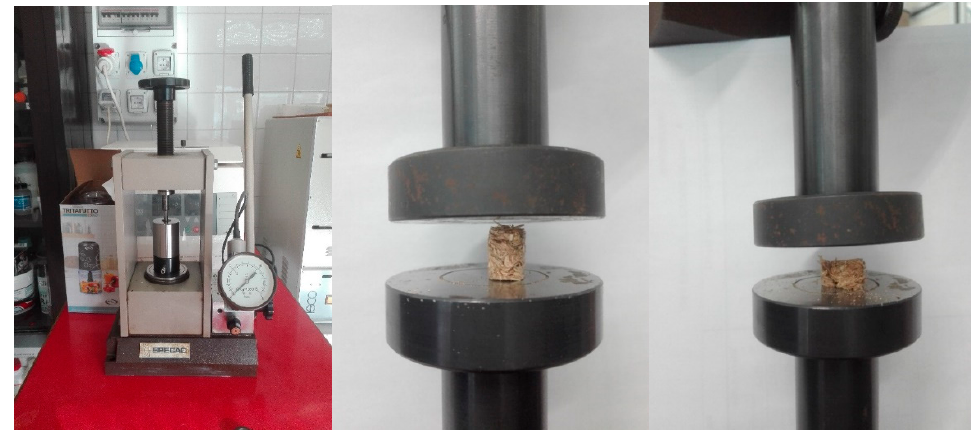
Figure 4. Axial compressive test .